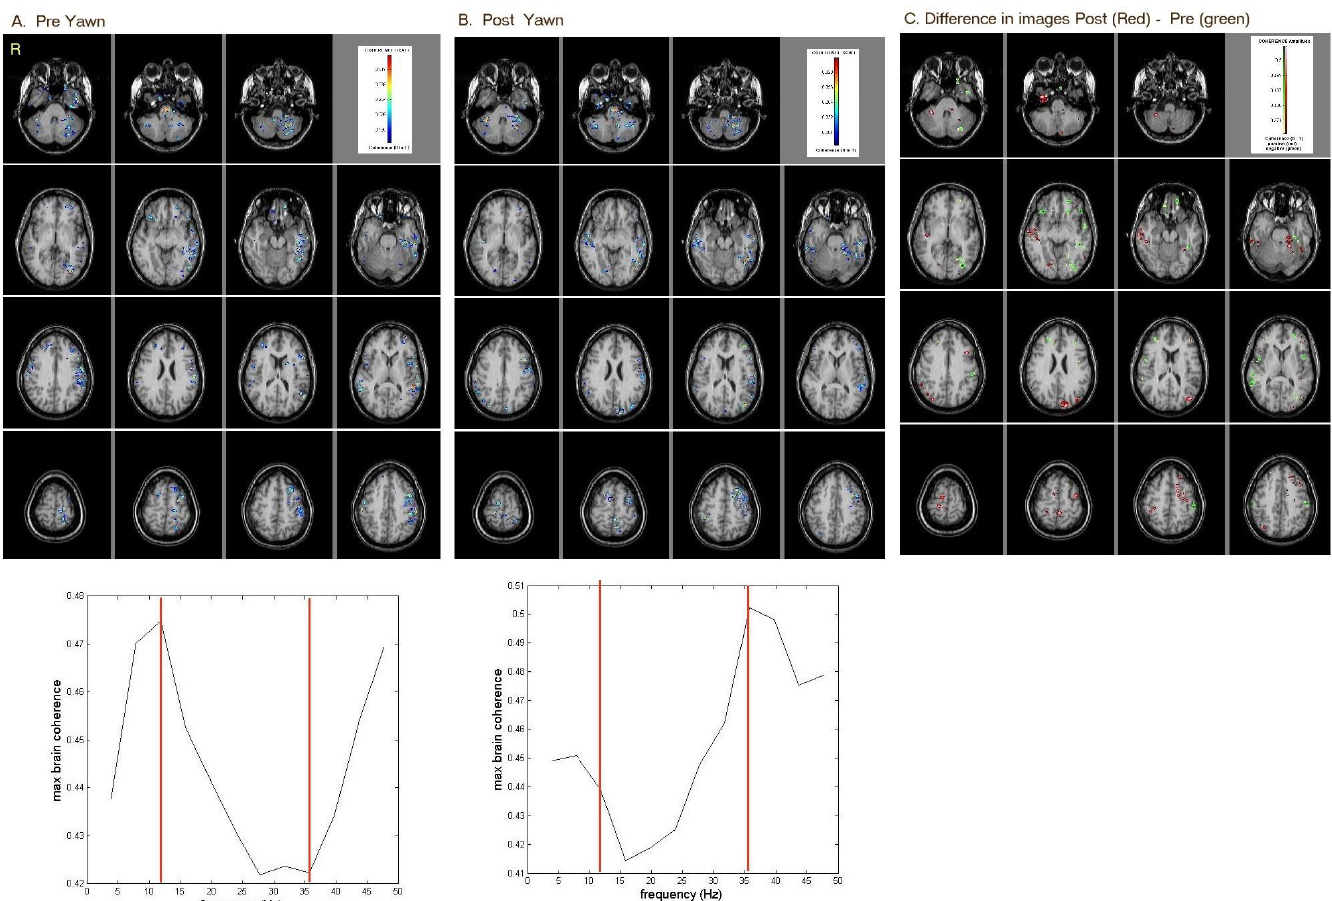
Figure 1. MEG-CSI results of resting-state brain-coherence activity ( A ) pre-sensory trick; ( B ) post-sensory trick; ( C ) subtraction of both images showing post-sensory trick (red) minus pre-sensory trick (green) differences. Prior to sensory trick, areas in the inferior frontal, left cerebellum and left parietal were active. After sensory trick, areas in the occipital and left temporal were more active.